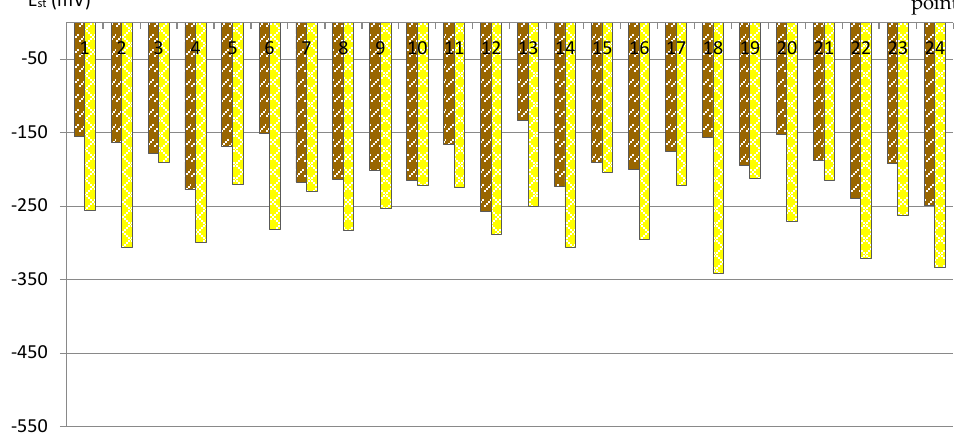
Figure 7. Half-cell potential of reinforcement measured in C_I_a specimens. Meanwhile, the results obtained from the measurements on C_I_n specimens (with Portland cement but without an air-entraining agent) were much lower—at 22 measurement points they exceeded E st = − 300 mV, including 12 points lower than E st = − 350 mV (Figure 8), which indicated a 95% probability of corrosion of the reinforcement in these areas.